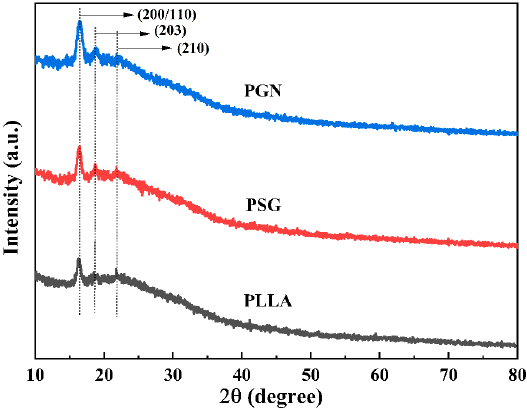
Figure 3. XRD patterns of neat PLLA, PSG and PGN nanocomposite films.